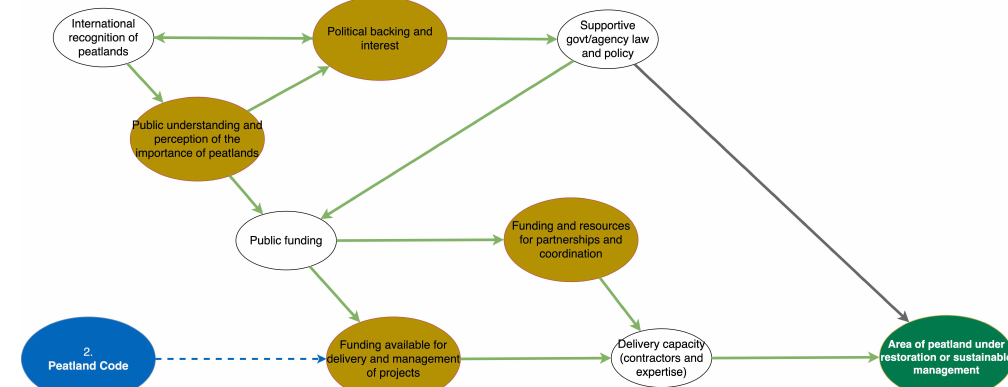
Figure 3. Submap tracing causal flow from ‘Peatland Code’. This bespoke submap was created by including nodes on the path between the ‘’Peatland Code and ‘Area of Peatland under restoration or sustainable management’ and connected nodes via funding which reflected the material from